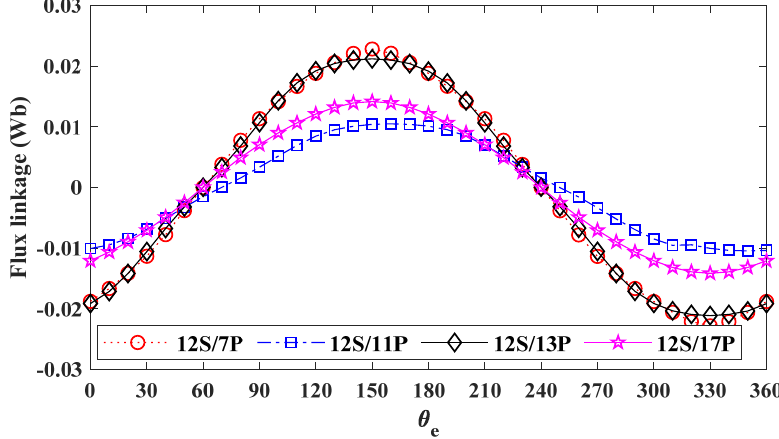
Figure 4. No-load operation flux linkages of all feasible combinations.